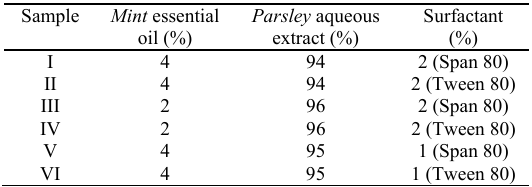
Table 1. The percentage of nanoemulsion component.